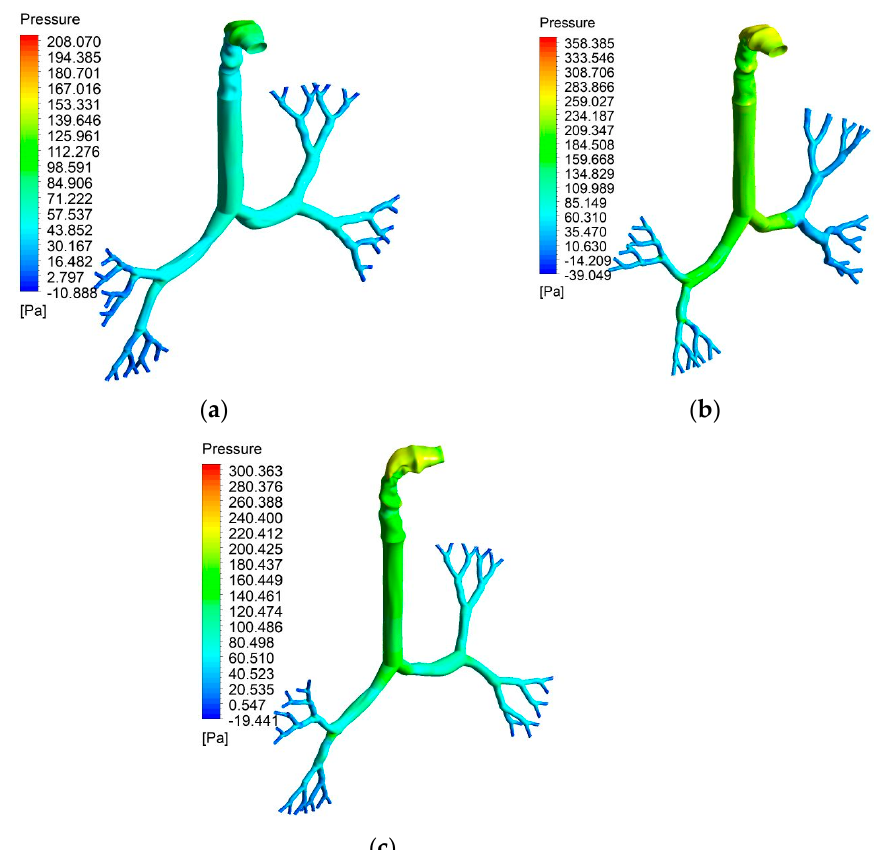
Figure 7. Pressure variation in the mouth-throat area and upper airways for three different lung sizes at 60 L/min flow rate: ( a ) 50-year-old lung, ( b ) 60-year-old lung, and ( c ) 70-year-old lung.